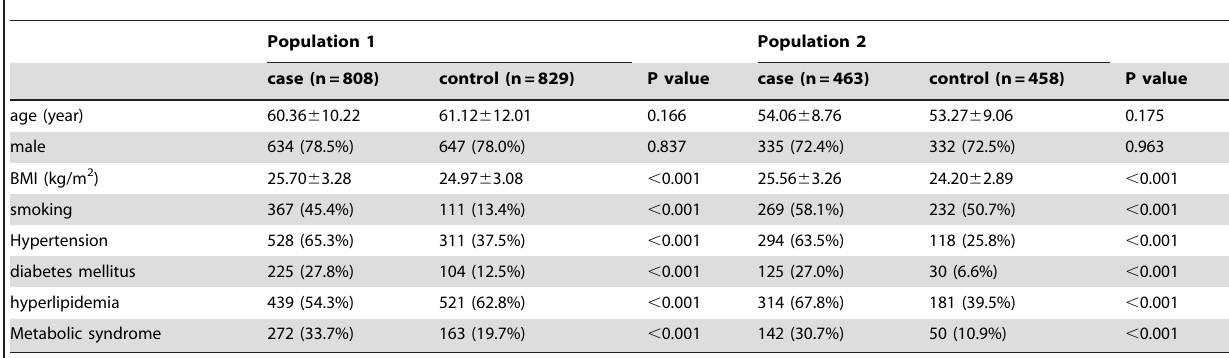
Table 2. Characteristics of